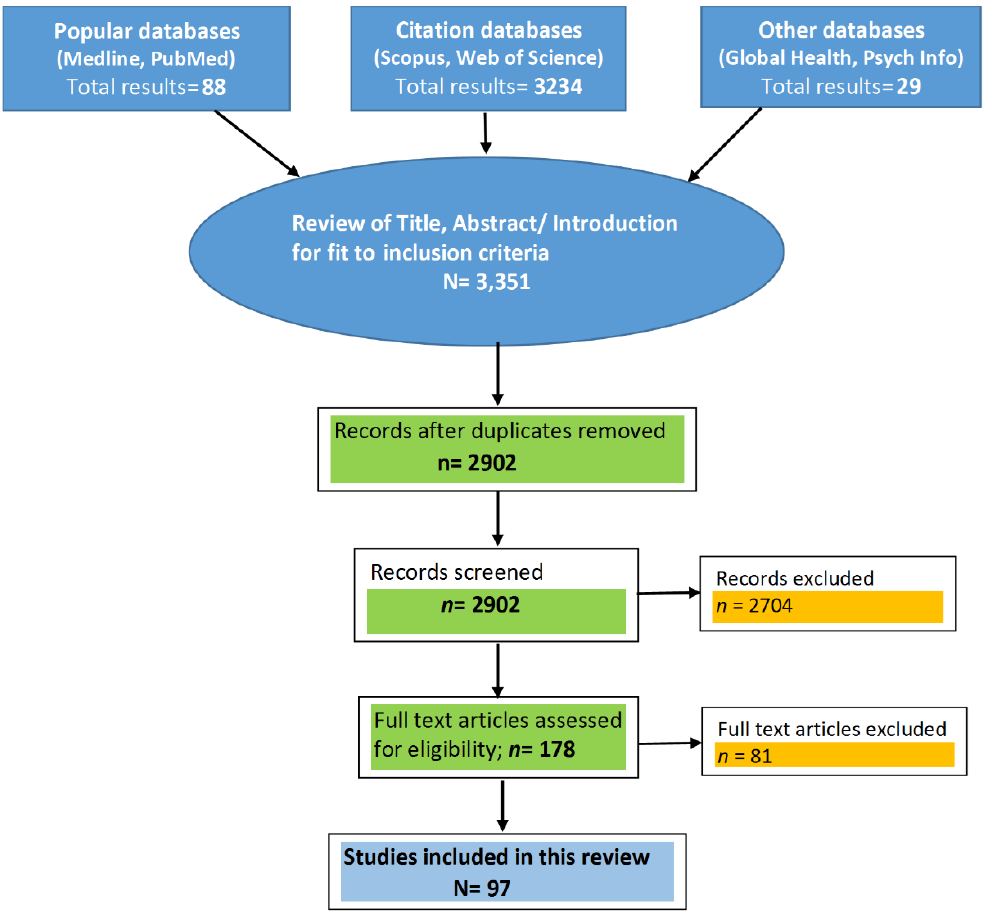
Figure 1. Flow chart showing the literature search.